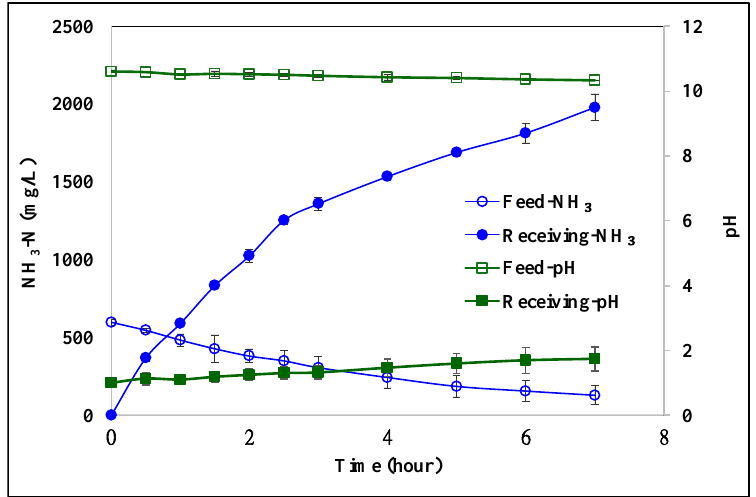
Figure 5. The NH 3 -N concentrations and pH in both feed and receiving solutions as a function of time using PTFE hollow fiber membranes (receiving solution: 0.1 M H 2 SO 4 ).